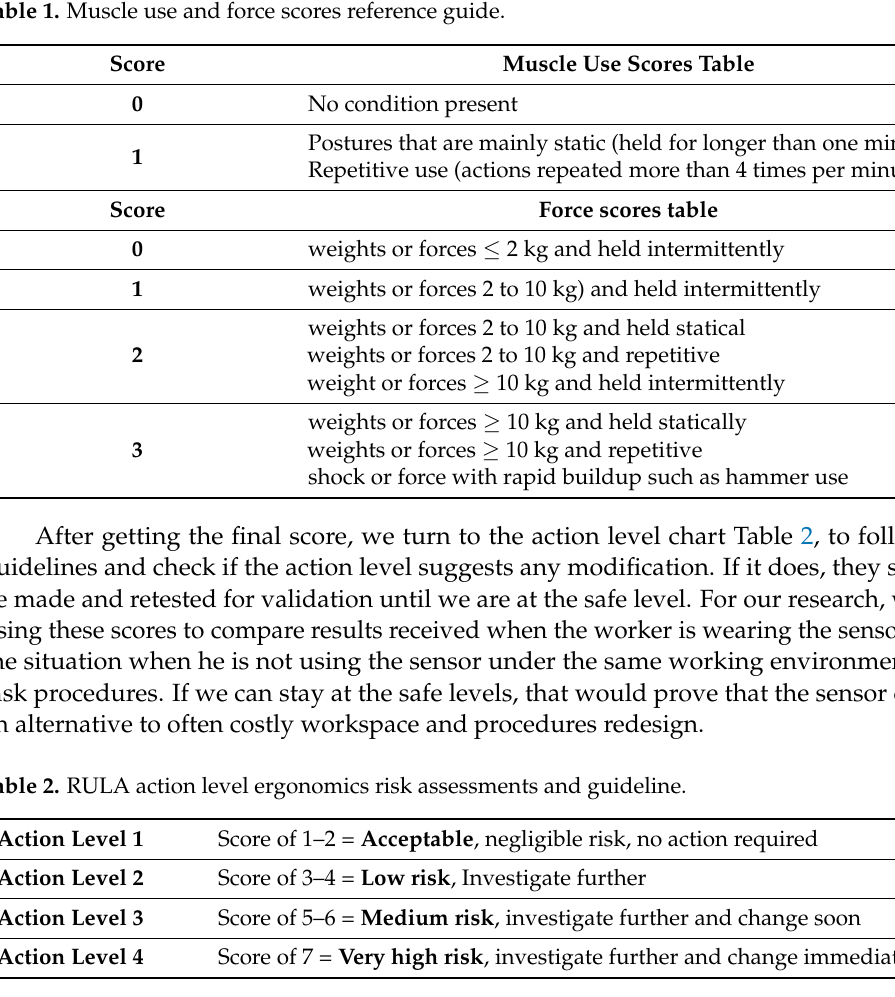
Table 1. Muscle use and force scores reference guide. Score Muscle Use Scores Table 0 No condition present Postures that are mainly static (held for longer than one minute) 1 Repetitive use (actions repeated more than 4 times per minute) Score Force scores table 0